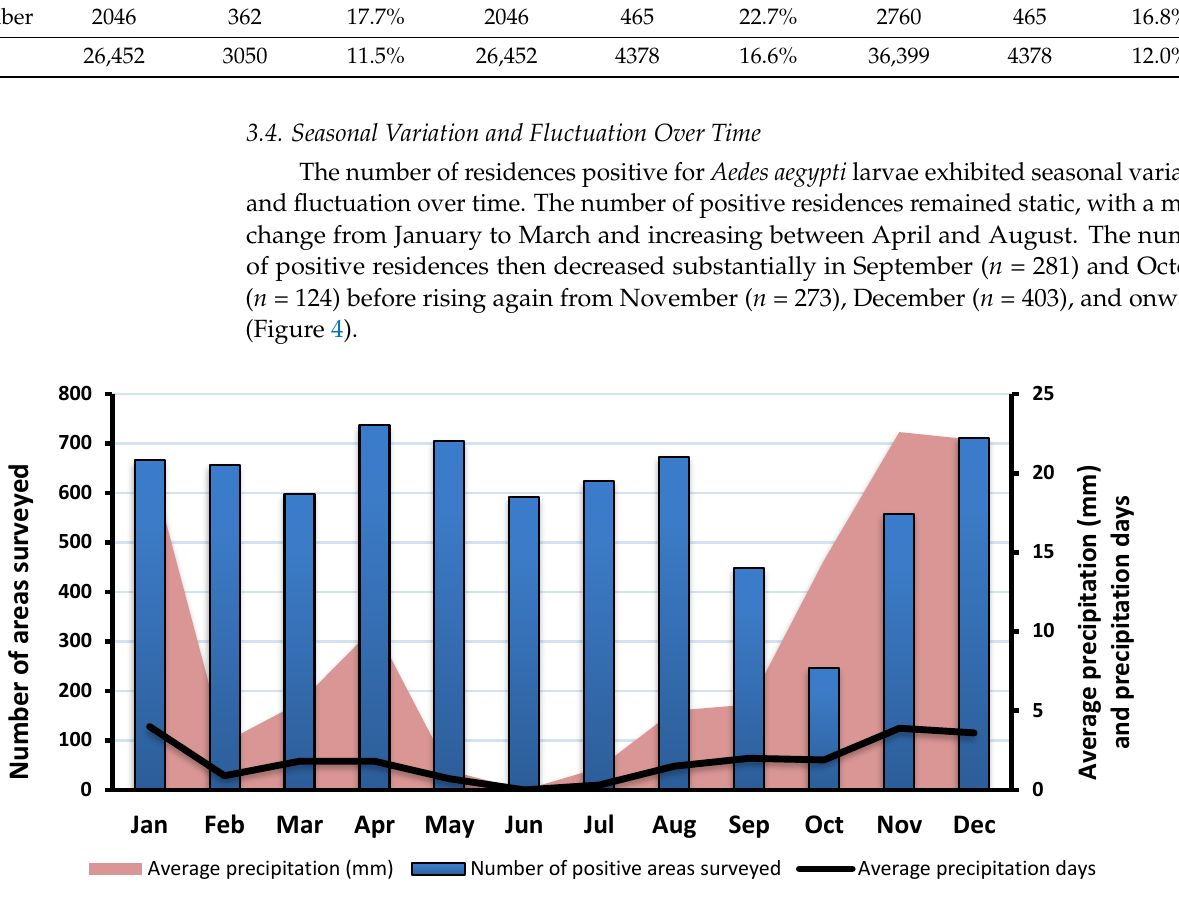
Figure 4. Monthly number of areas surveyed that were positive for Aedes aegypti larvae, mean precipitation, and number of days precipitation occurred.